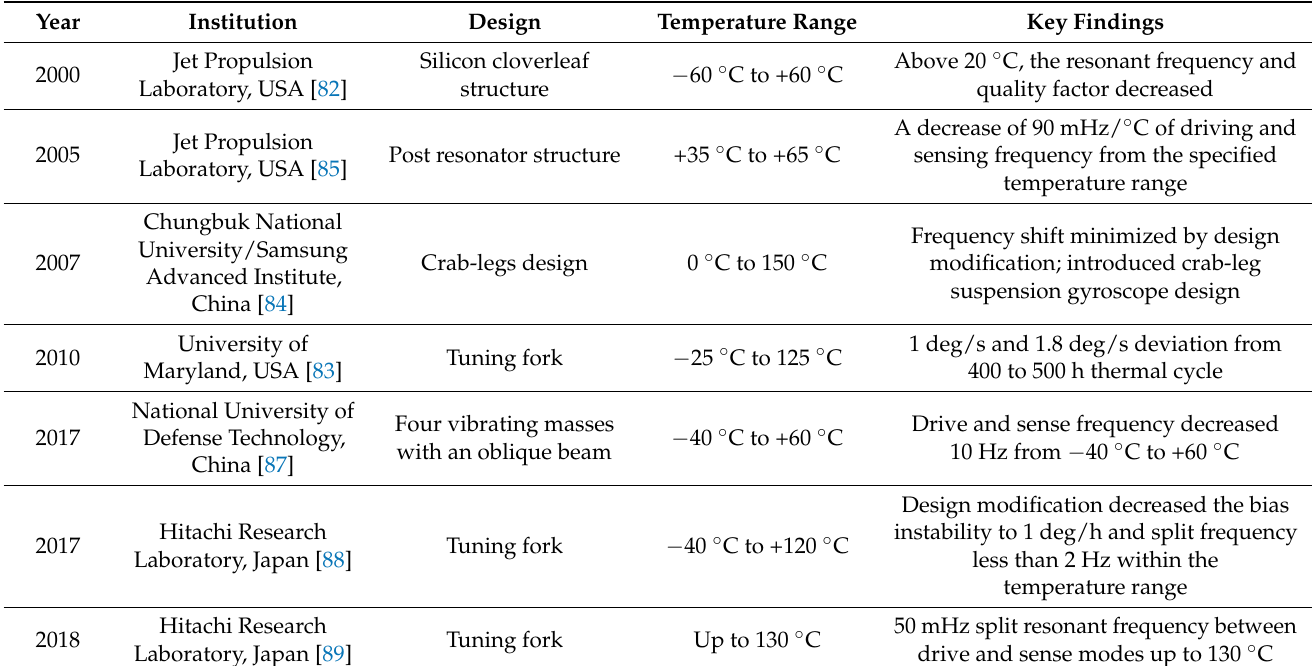
Table 2. Summary of different research group findings of gyroscope performances on temperature characteristics.